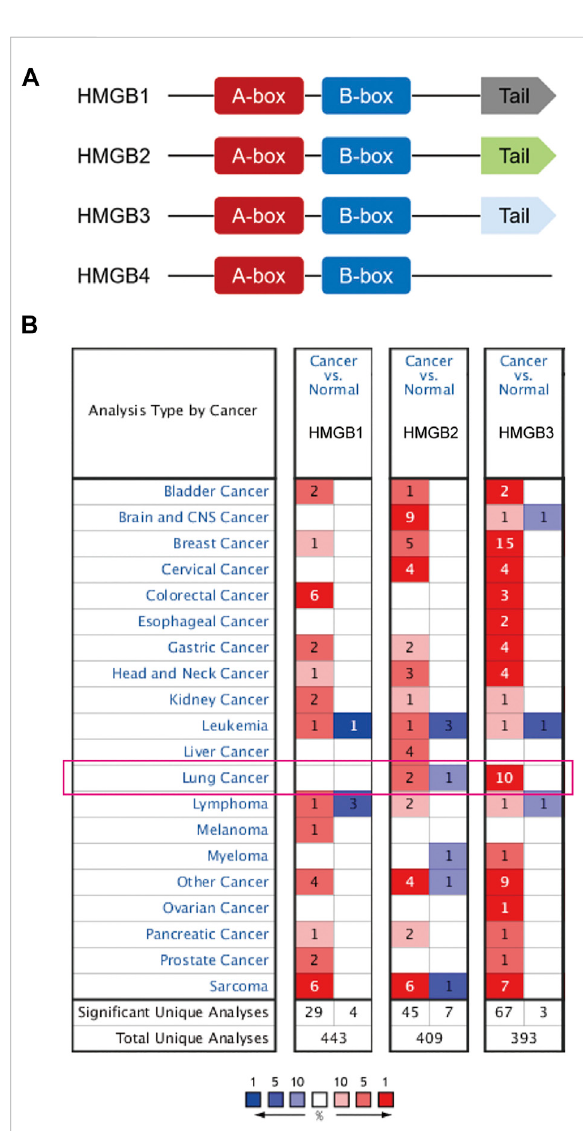
FIGURE 1 (A) Schematic diagram of HMGB protein family